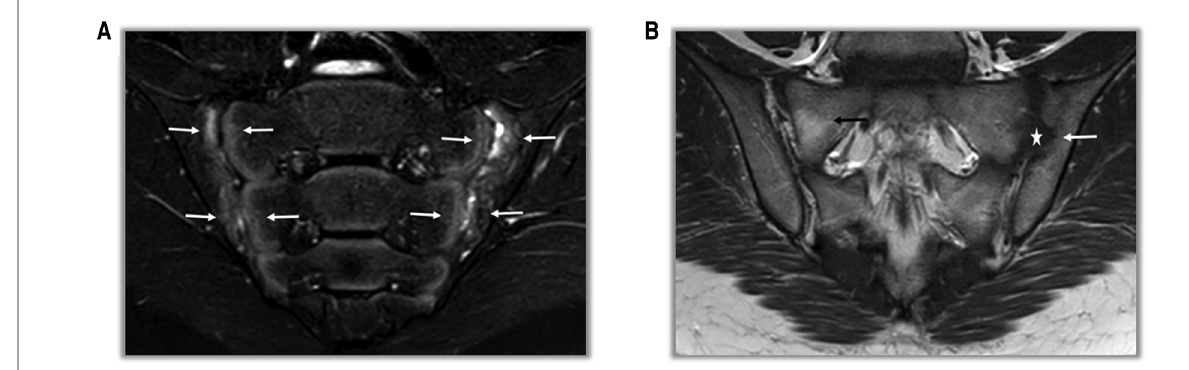
FIGURE 2 MRI fi ndings in SpA patients. ( A ) On T2-weighted fat-suppressed coronal sections, areas of bone marrow edema consistent with acute sacroiliitis are observed on the facing sides of the bilateral sacroiliac joint (white arrows). ( B ) On T1-weighted fat-free coronal sections, erosion and irregularities at the level of the left sacroiliac joint (white arrow) and pseudo-widening (star) of the joint space are observed. In the right sacroiliac joint, there is an appearance of fat replacement (black arrow) in the sacral